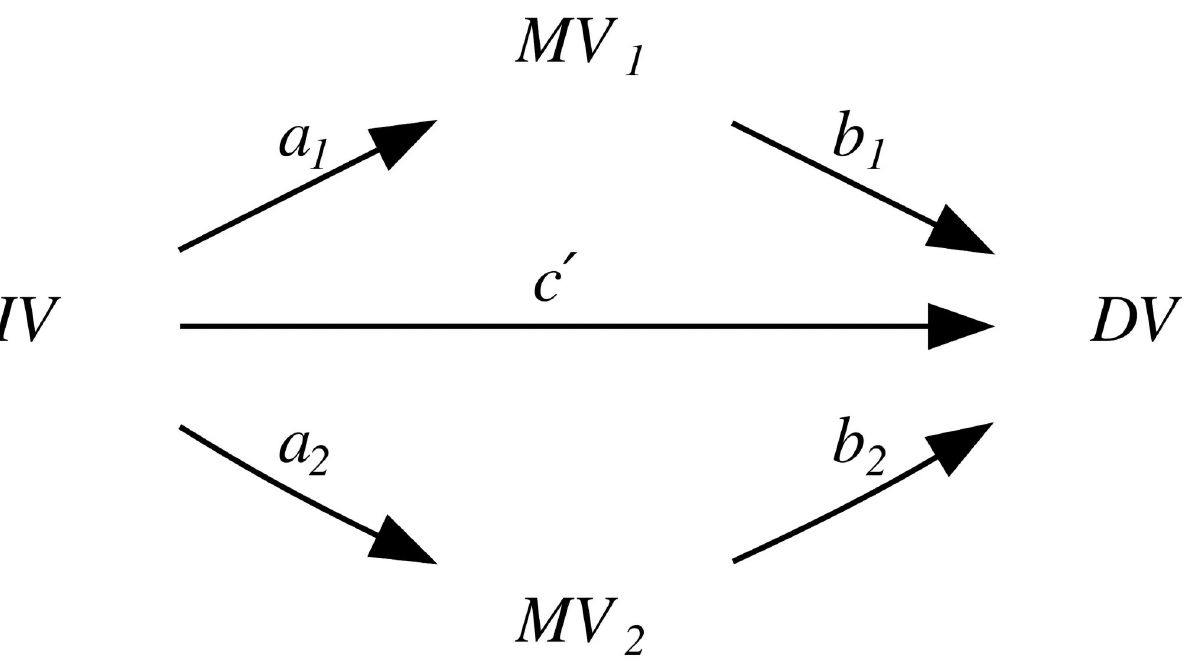
Fig 6. Visual representation of the path model showing the IV (Africa vs the rest of the world), the DV (tone) and the two mediators MV 1 and MV 2 ( ASPM -D and MCPH1 -D), as well as all the path coefficients ( a 1 , a 2 , b 1 , b 2 and c 0 ). Please note that a similar model was also experimentally implemented in a Bayesian framework as simultaneous multiple mediation which explicitly controls for family and (meta)population as random